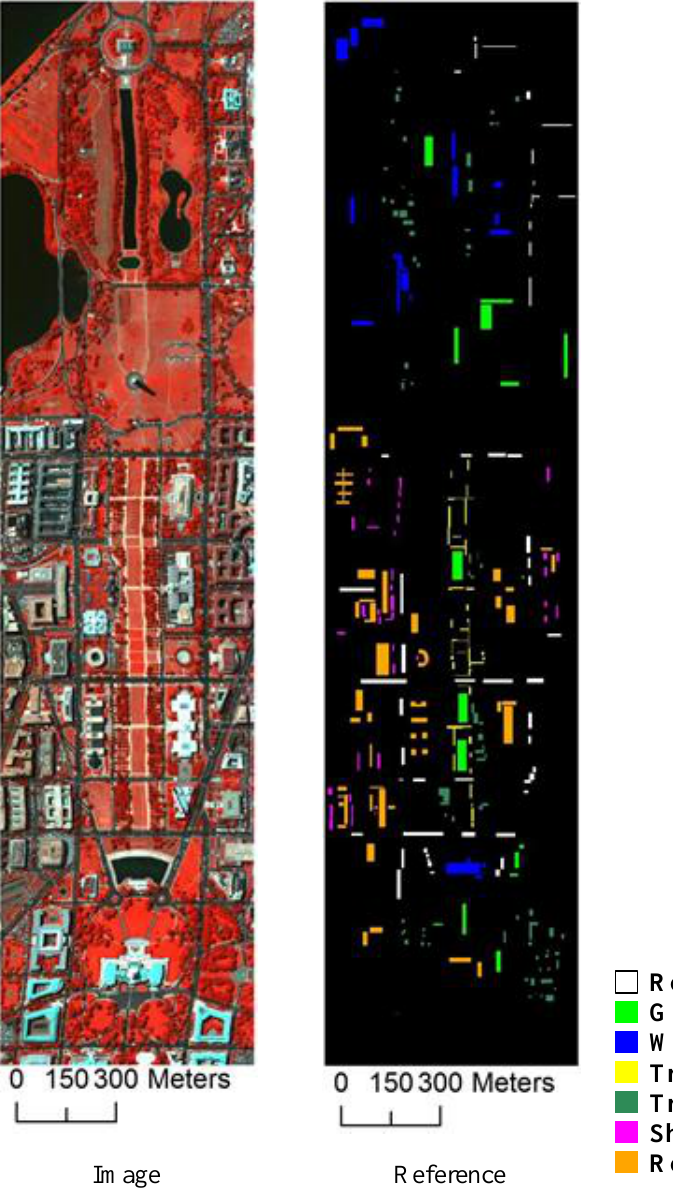
Figure 4. The Washington DC image and its reference data.